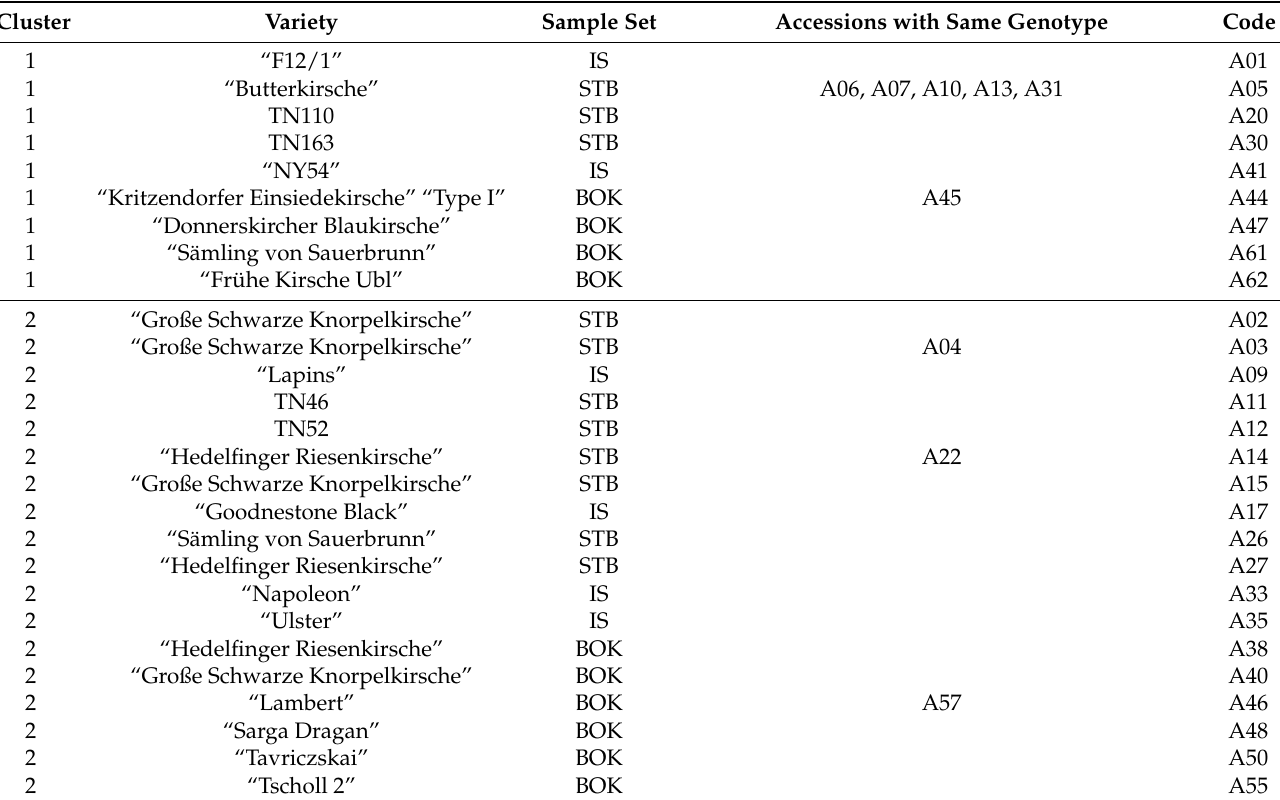
Figure 3. Membership probability of samples to the three identified clusters. Depiction of admixture. X-axis: individual samples, y-axis: membership probability to one of three clusters: 1: red, 2: green, 3: blue. Table 5. Composition of clusters, membership of Multilocus Genotypes according to DAPC based on SSR data. Column 4 shows the code of the accessions with the same genotype where applicable. STB = Stoob, IS = International Standard, BOK = BOKU, Vienna, TN = Tree number. Variety names in double quotes are internal working names for unidentified varieties in the germplasm collection.